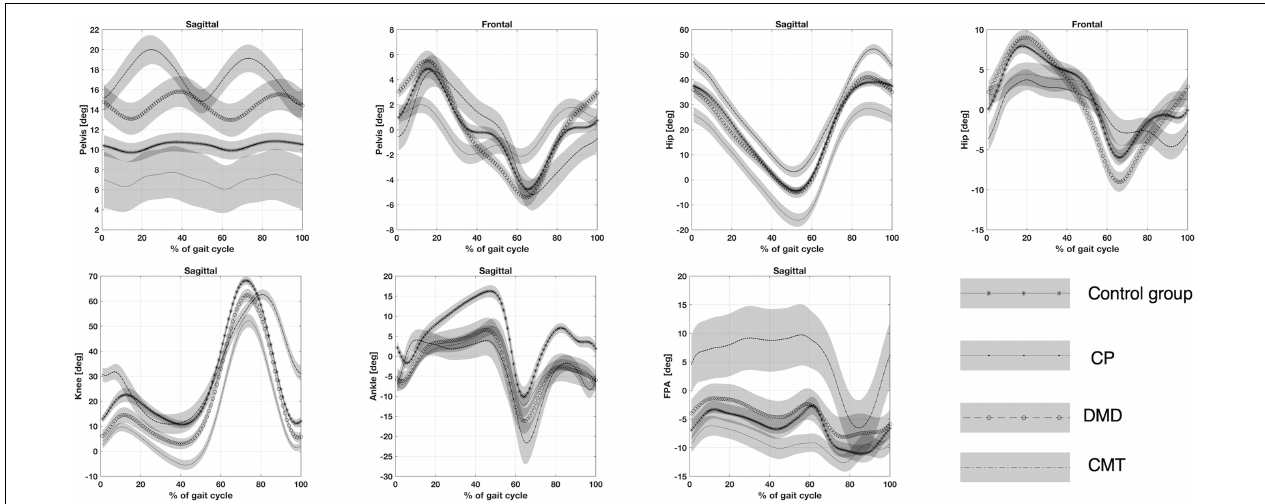
FIGURE 2 | Top panel (from left to right): Pelvis angle on the sagittal and the frontal plane. Hip angle on the sagittal and the frontal plane. Bottom panel (from left to right): Knee angle, Ankle angle on the sagittal plane and Foot progression angle (FPA) on the transversal plane. CP, participants with Cerebral Palsy;